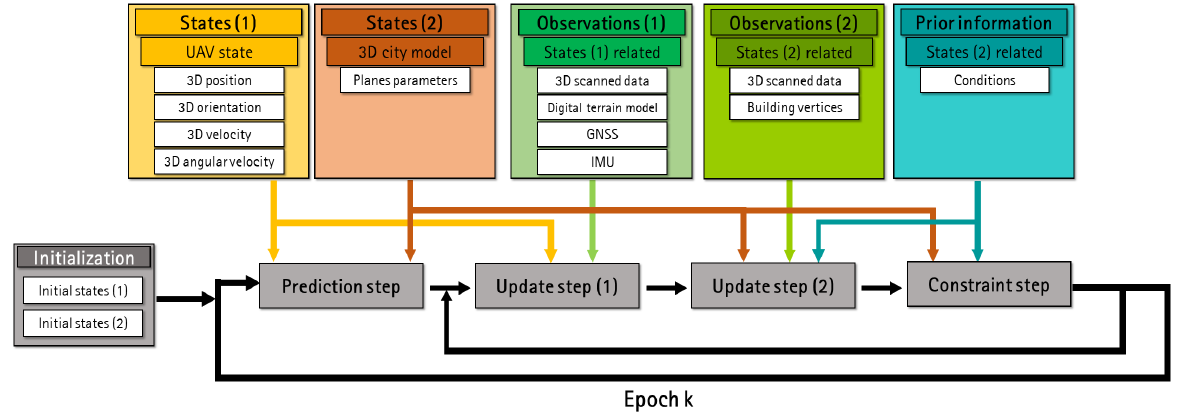
Figure 4. Simplified workflow of the DSIEKF